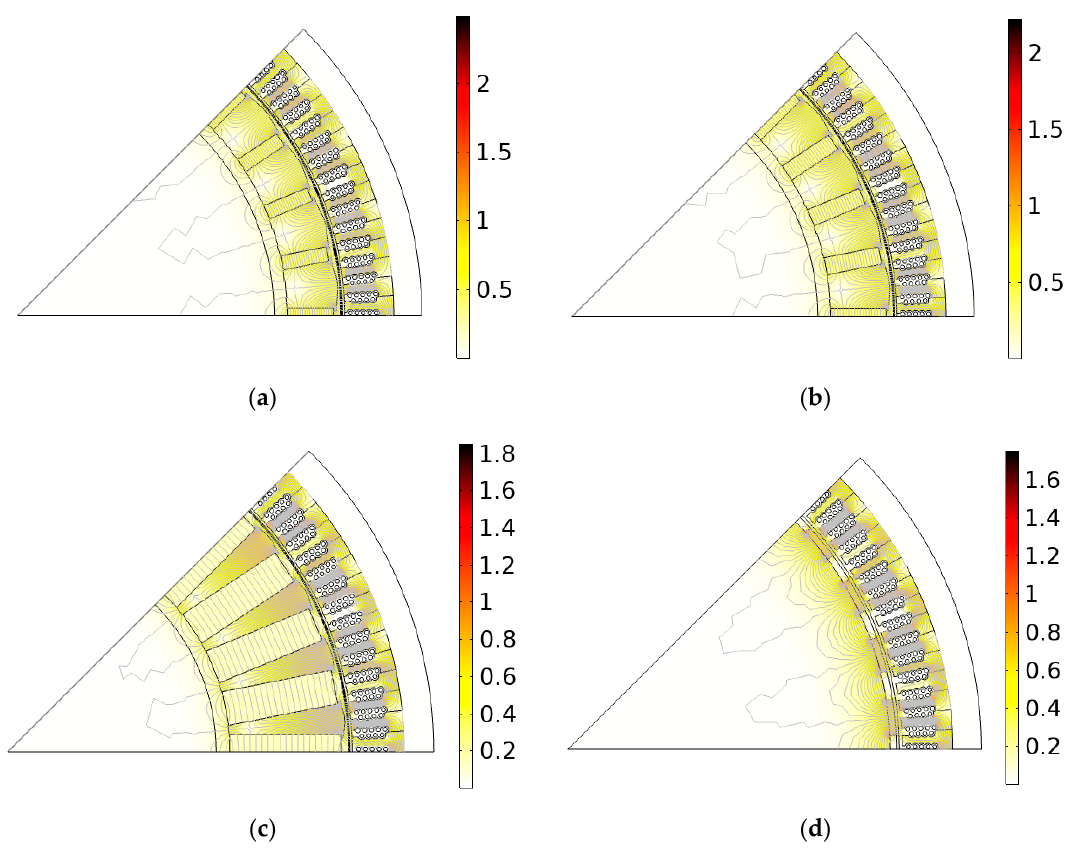
Figure 5. Topology of the generators and magnetic flux density [T]: ( a ) Case 1; ( b ) Case 2; ( c ) Hard ferrite; ( d ) NdFeB.